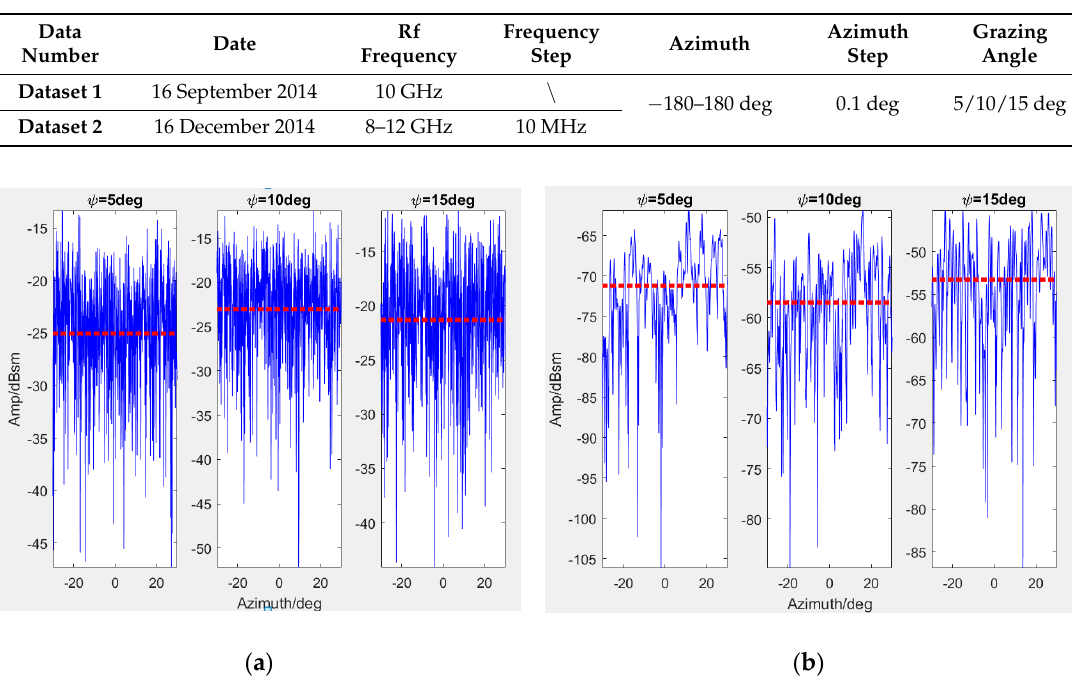
Table 3. Parameter setting of simulations.